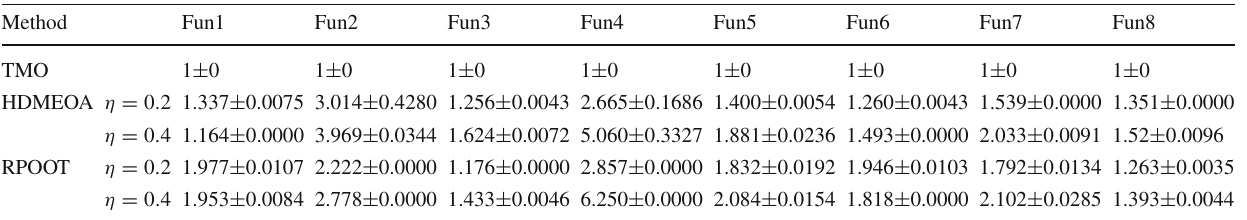
Table 7 MRST comparison of three methods under chaotic environmental changes